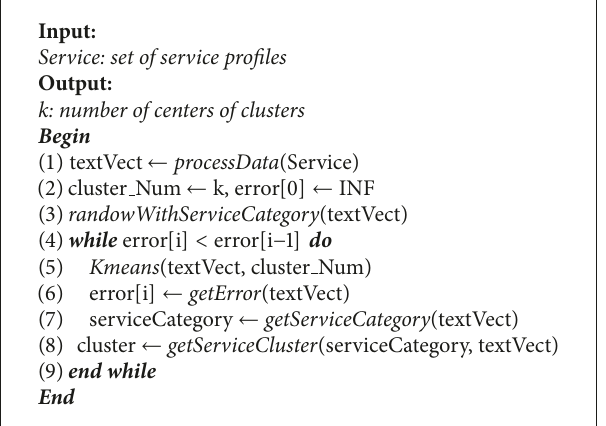
Algorithm 1: TIS clustering based on